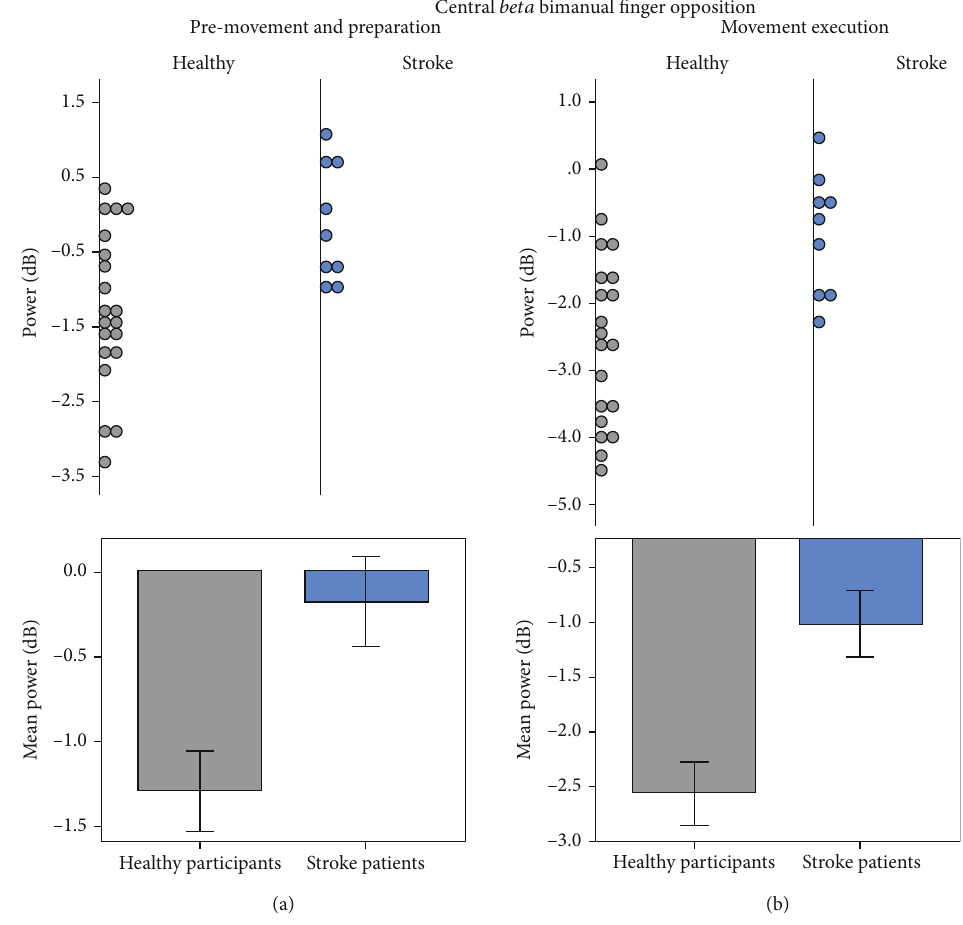
Figure 2: Beta power relative to baseline. Both groups showed desynchronization (negative mean power) with bimanual fi nger opposition. However, stroke patients did not increase beta desynchronization as much as the healthy controls. Signi fi cant di ff erences ( p < 0 : 05 ) are observed between healthy participants and stroke patients in power of the beta rhythm in the premovement and preparation and in the time-locked beginning of bimanual fi nger opposition. Error bars represent ± 1